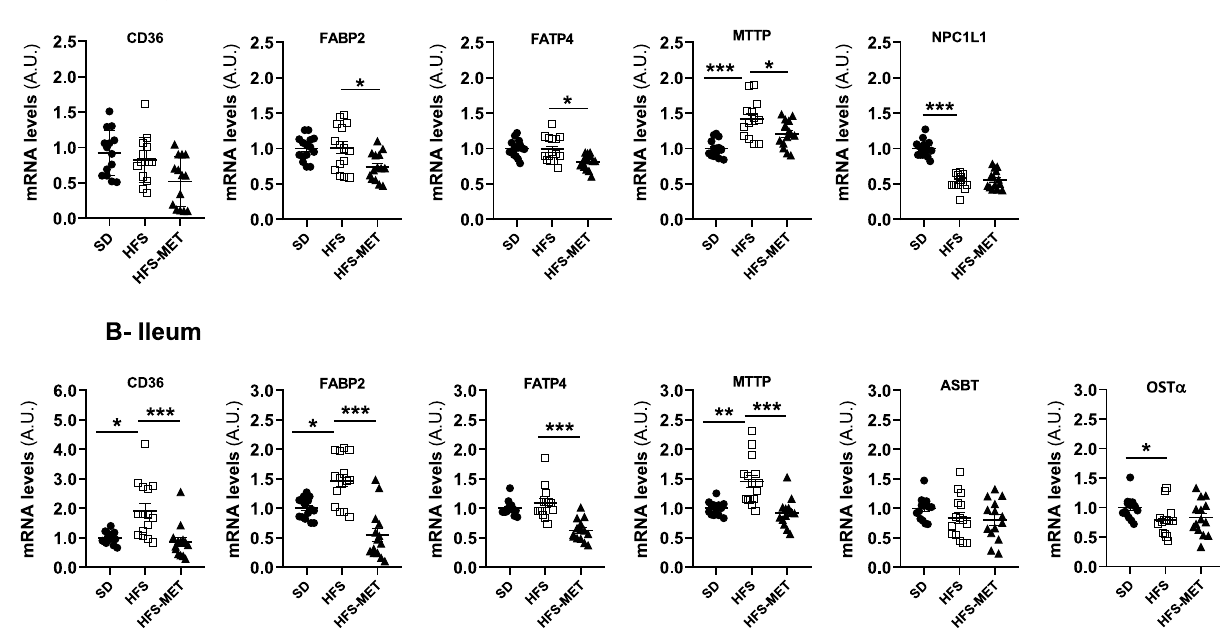
Figure 3. Effects of HFS diet and metformin treatment on the expression of lipid absorption-related genes in the jejunum and the ileum. The mRNA levels of the targeted genes were determined by RT-qPCR in ( A ) the jejunum and ( B ) the ileum of 15 to 18 mice per group ( SD standard diet, HFS high fat high sucrose diet, HFS- MET HFS diet with metformin supplementation). *p < 0.05, **p < 0.01, ***p < 0.001, determined by ANOVA followed by Tukey’s multiple comparison